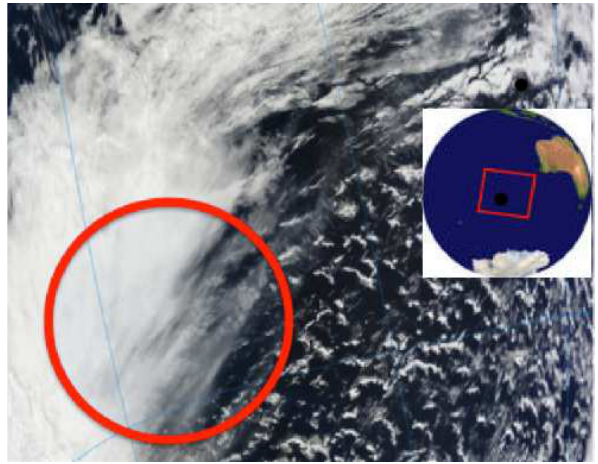
Fig. 22. MODIS RGB image of the scenario used for the compari- son with LBLMS. The red circle highlights the cloudy regions used for the test.